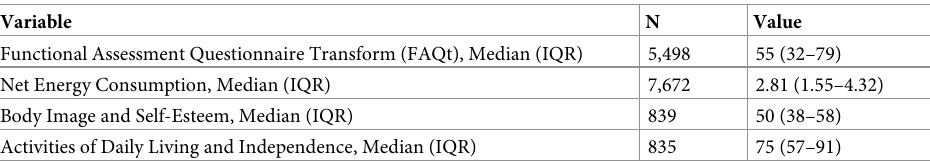
Table 5. Mobility, energy, quality of